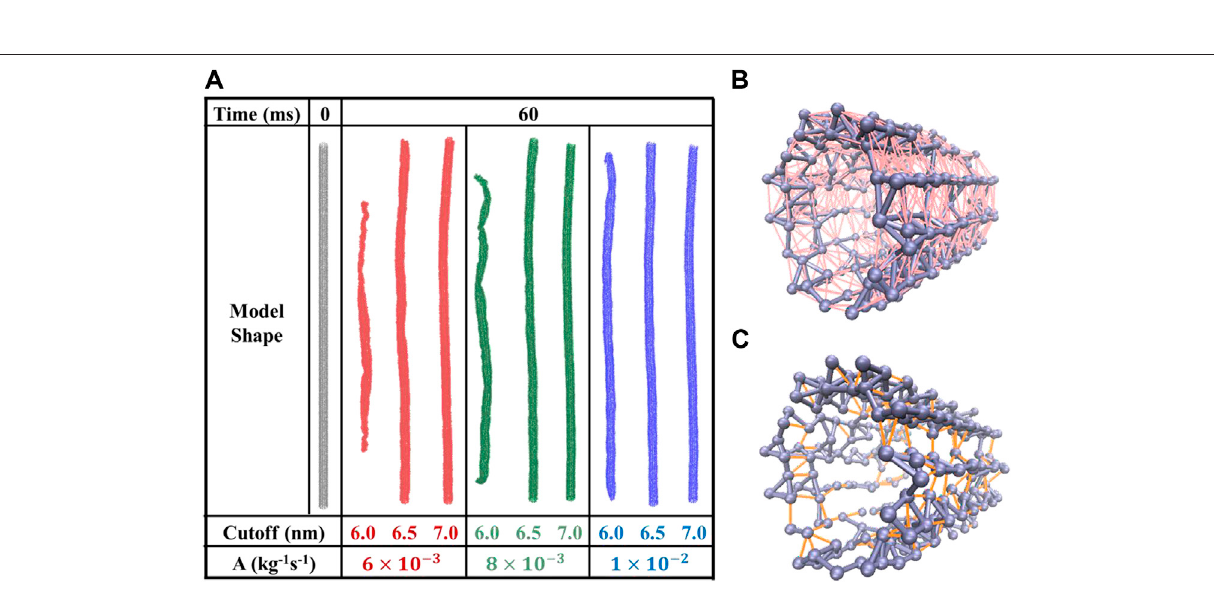
FIGURE 5 | (A) The structures of constructed UCG models for microtubules at the initial simulation time and after 60 ms. The cutoff distances adopt the values of 6.0, 6.5,and 7.0 nmforthree models, withthetested parameter A adopting 6 × 10 − 3 ,8 × 10 − 3 ,and 1 × 10 − 2 kg − 1 s − 1 ,respectively. (B) TheUCGbond distances below 4.4 nm are colored in gray, while those bonds in 4.4 – 6.6 nm are in pink. (C) The UCG bonds below 4.0 nm in gray and those in 4.0 – 4.4 nm are colored in